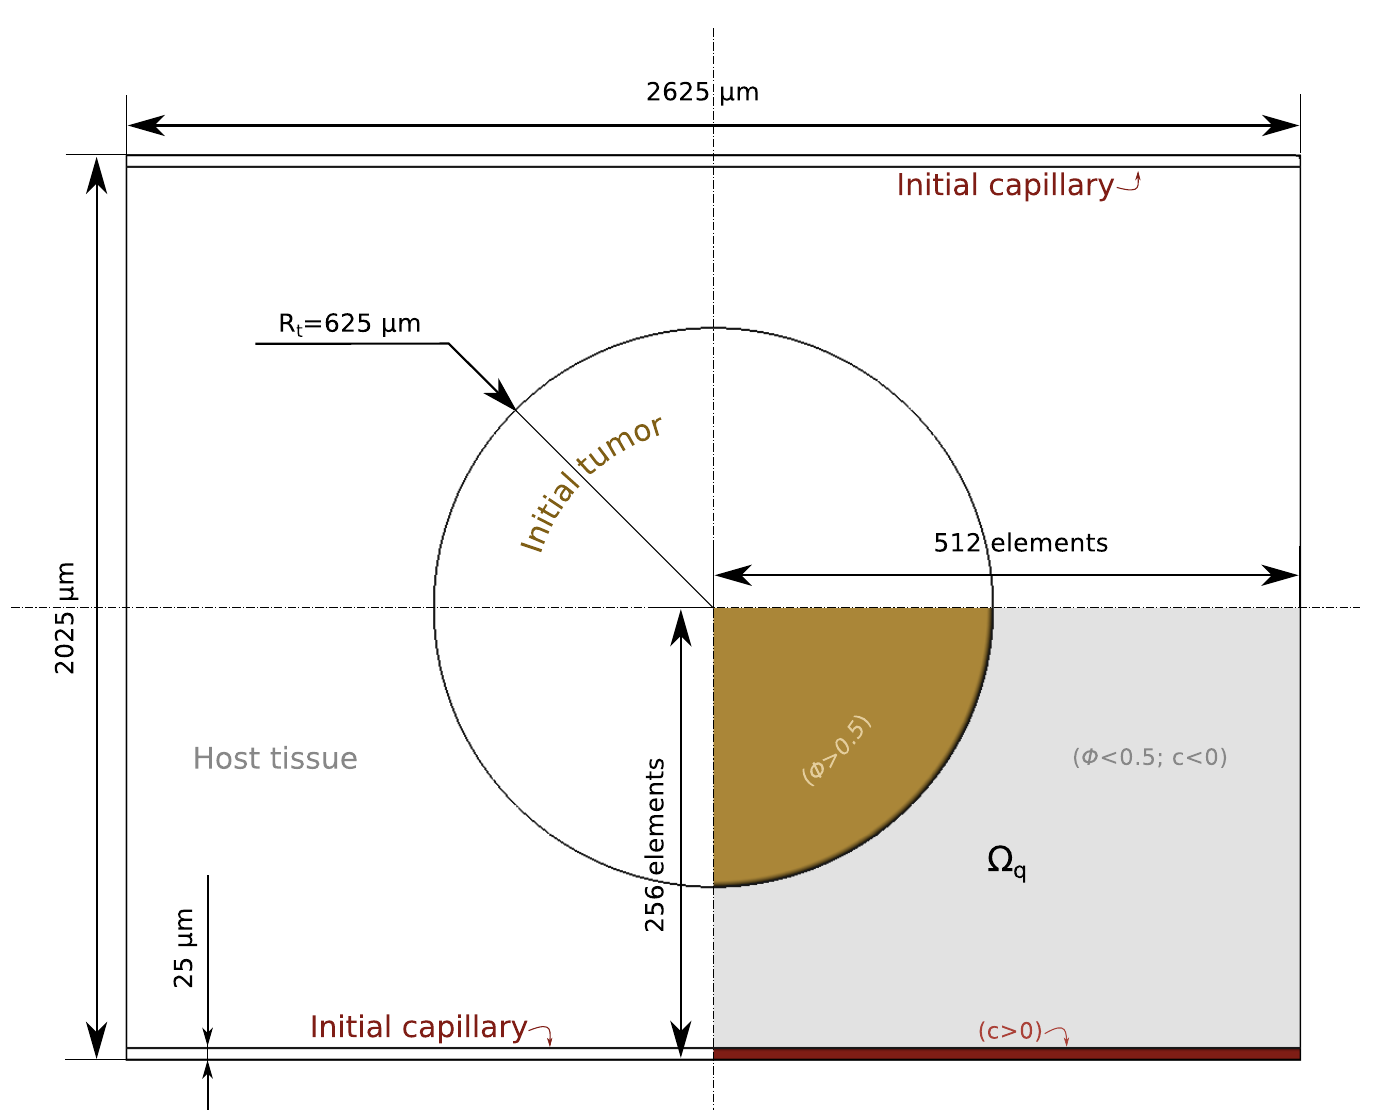
Fig 4. Problem setup. The domain of the problem represents a rectangular tissue of size 2625 µ m × 2025 µ m with a circular initial tumor (brown) and two capillaries (red). Using the symmetries of this setup, the simulations may be performed on a quarter of the tissue, the domain Ω q .